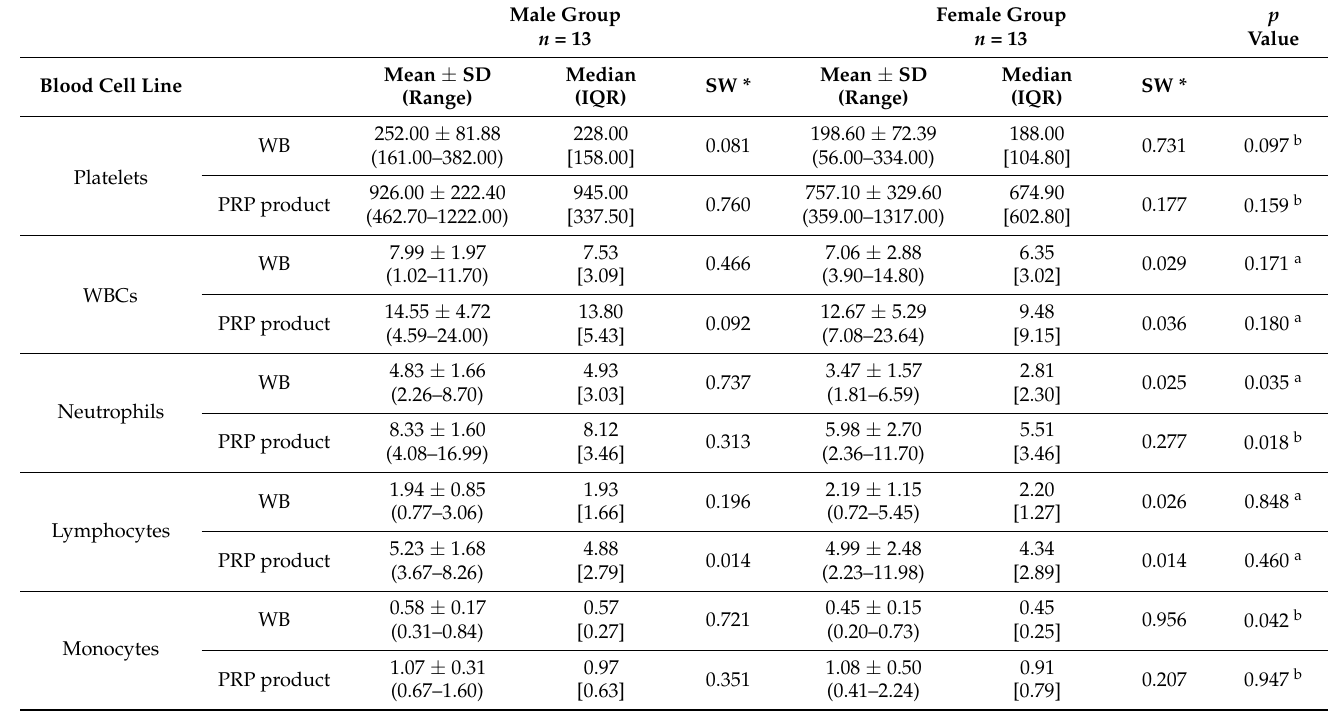
Table 1. Platelet and WBC counts (cells × 10 6 /mL) in WB and in the final PRP product prepared by using the Easy PRP Kit in male and female volunteers.